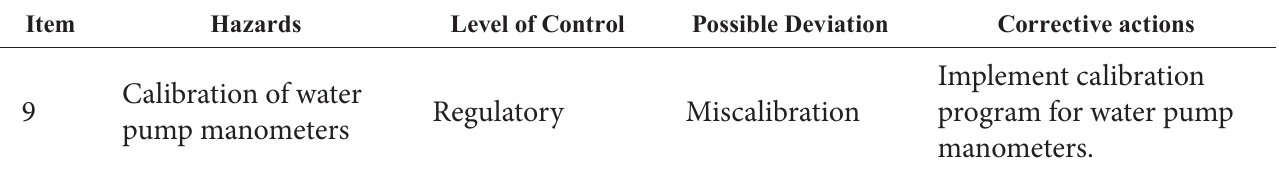
TABLE I - P otential hazards identified during the HACCP analysis of the water purification system Item